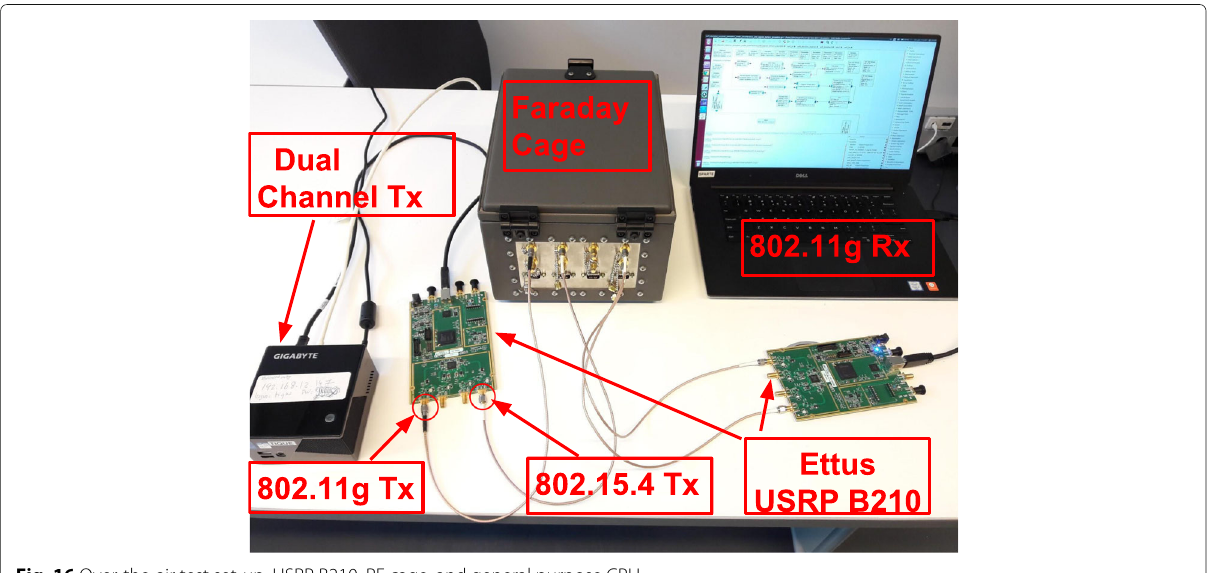
Fig. 16 Over-the-air test set-up: USRP B210, RF cage, and general purpose CPU